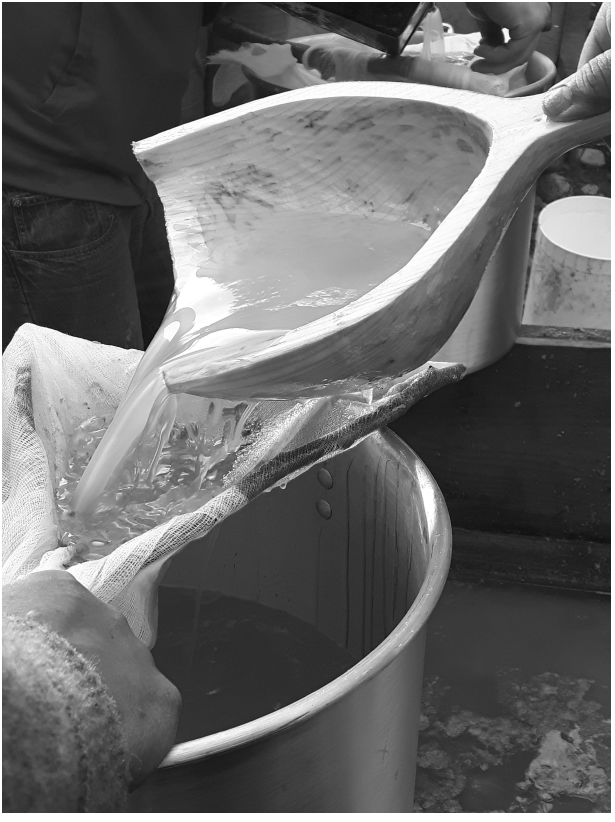
Fig. 3 . Sluq, Nuxalk eulachon ( Thaleichthys pacificus ) grease, being poured into jars for